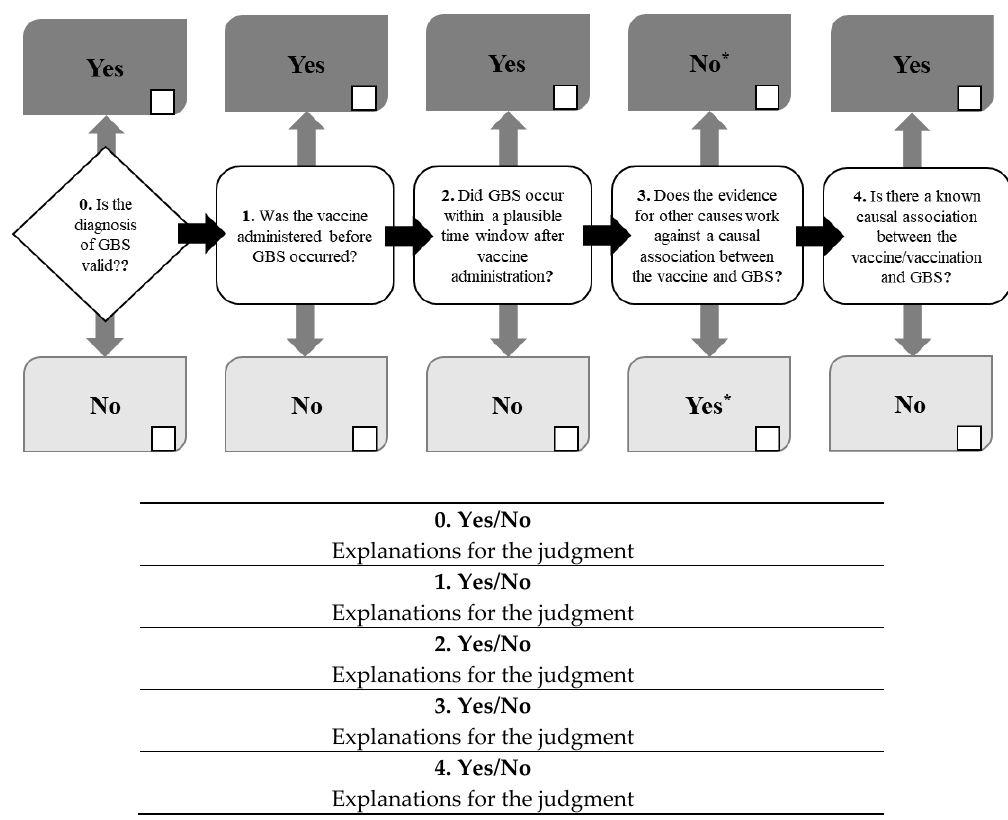
Figure 3. Causality assessment guidelines for Guillain–Barré syndrome following immunization: Causality assessment algorithm. (* Unlike other questions, for this question, “No” implies a causal association, and “Yes” implies little causal association.).